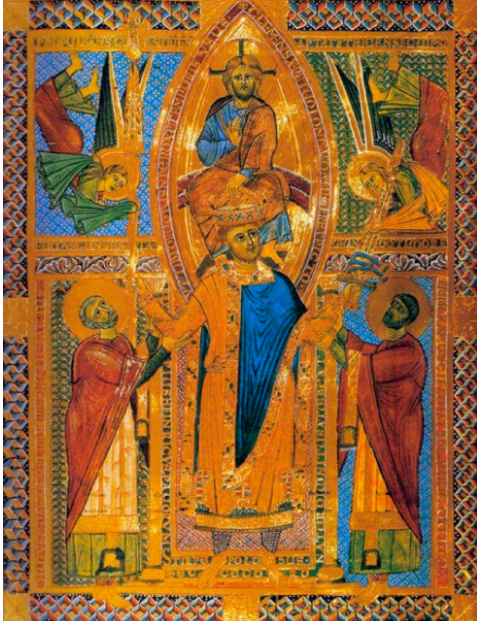
Figure 3. Henry II Crowned by Christ , illumination, 1002–1003. Munich, Bayerische